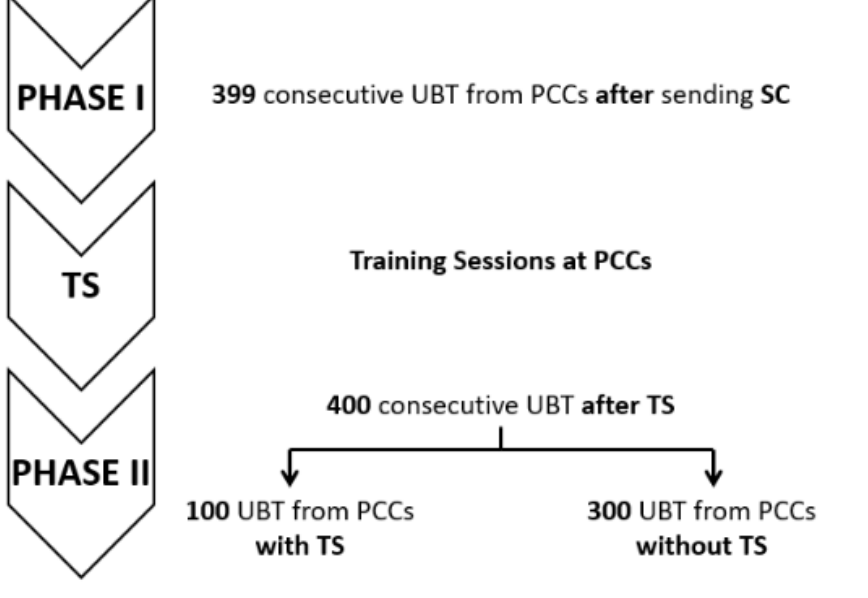
Figure 3. Study design and the phases that compose it. PCCs: primary care centres; TS: training sessions; SC: specific counselling; UBT: urea breath test. Table 2. Indications for eradication according to the III Spanish Consensus Conference on Helicobacter pylori infection